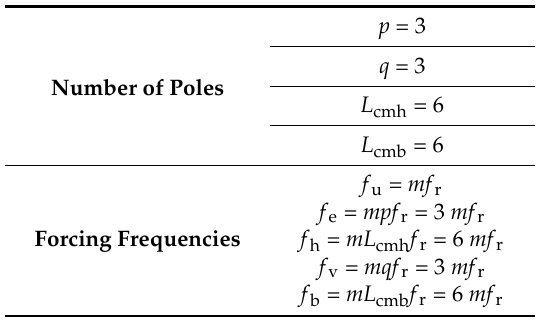
Table 1. Major forcing frequencies of the